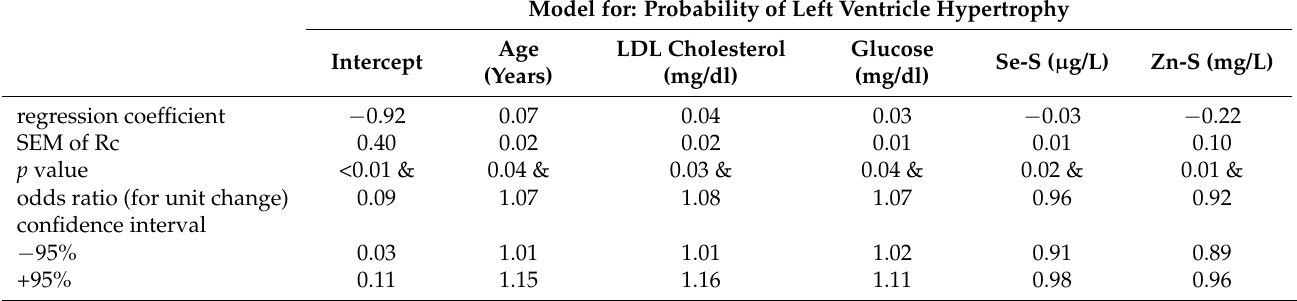
Table 5. Results of logistic regression analysis in the study group.